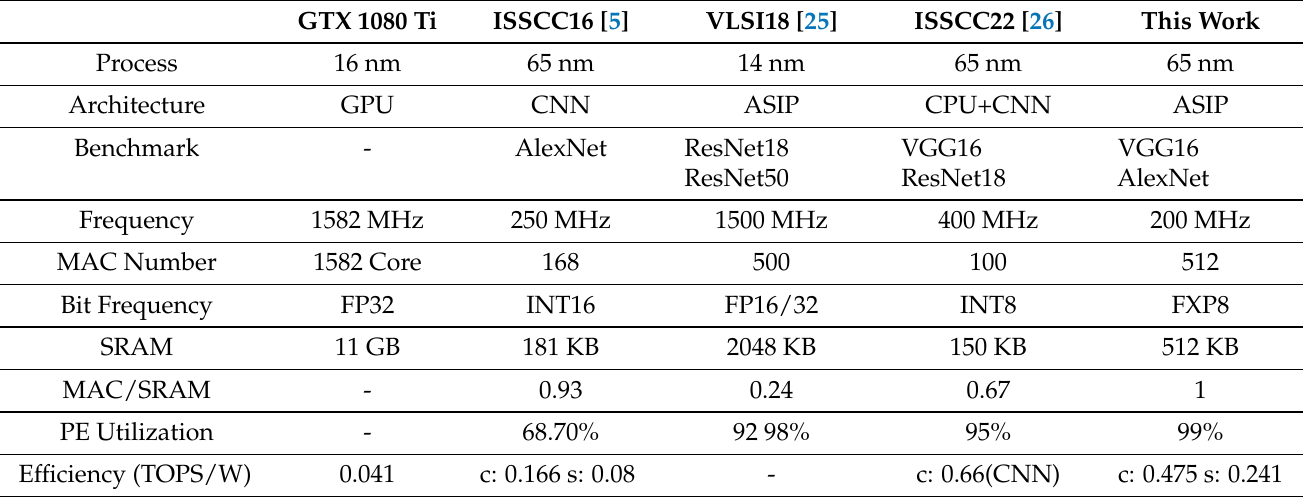
Table 9. Comparison with state-of-the-art